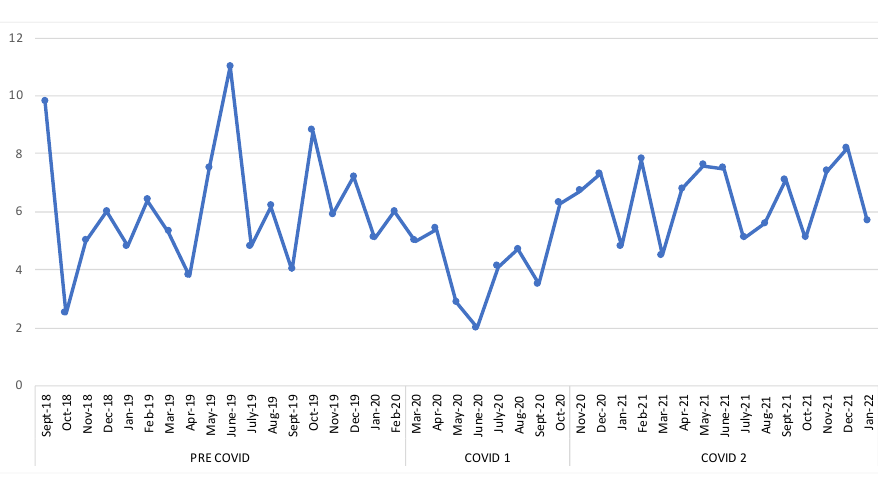
Table 1. Distribution of patients according to frequency, intensity of attacks, and use of prophylaxis in the general sample and in the different periods. SD: standard deviation. Total Patients N 418